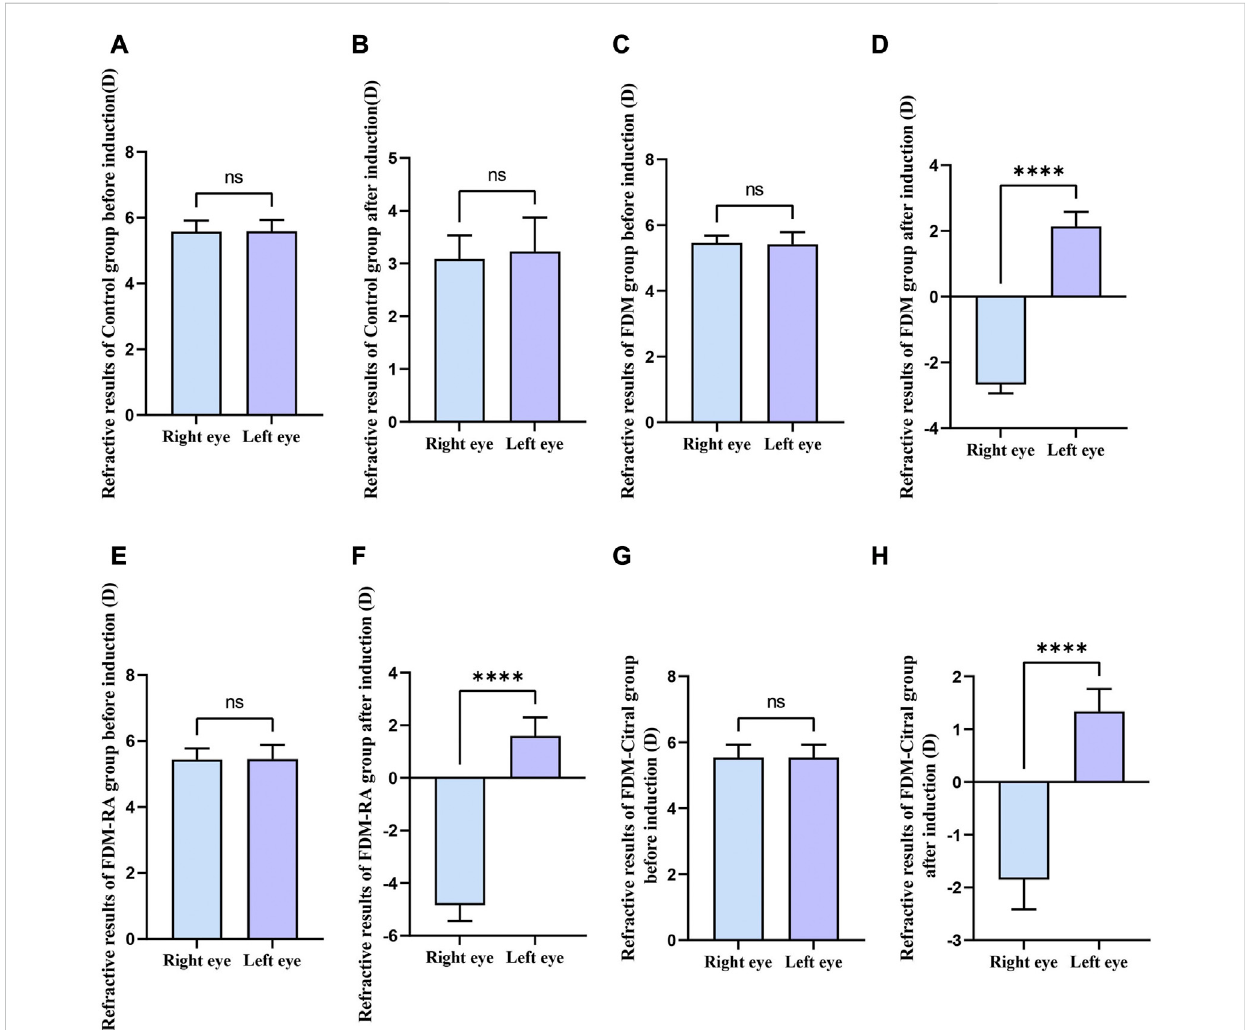
FIGURE 3 Comparison of RE between the left and right eyes before and after induction in each group (D). Note. (A) , Comparison of RE between left and right eyes before induction in Control group; (B) , Comparison of RE between left and right eyes after induction in Control group; (C) , Comparison of RE between left and right eyes before induction in FDM group; (D) , Comparison of RE between left and right eyes after induction in FDM group; (E) , ComparisonofREbetweenleftandrighteyesbeforeinductioninFDM+RAgroup; (F) ,ComparisonofREbetweenleftandrighteyesafterinduction in FDM + RA group; (G) , Comparison of RE between left and right eyes before induction in FDM + Citral group; (H) , Comparison of RE between left and right eyes after induction in FDM + Citral group; (D) , diopter; ns means that the difference is not statistically signi fi cant; **** Indicates p ≤ 0.0001.